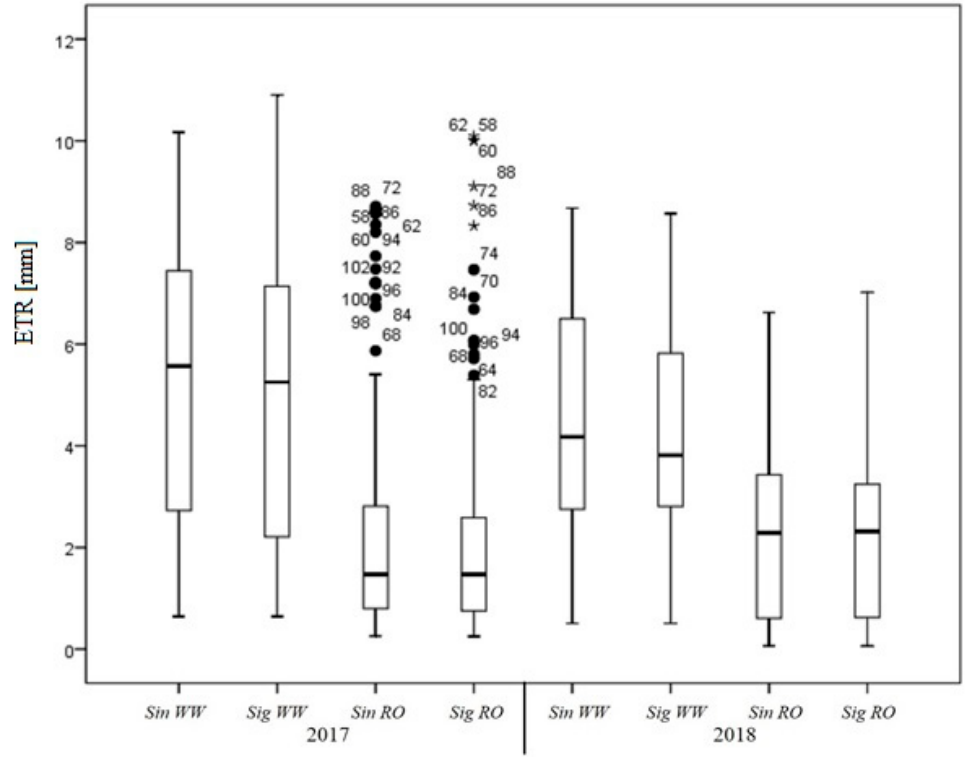
Figure 7. Daily mean evapotranspiration rates ( ETR ) of treated soybean varieties ( Sinara : Sin ; Sigalia : Sig ) under unlimited ( WW ) and limited ( RO ) watering levels through two consecutive growing seasons (2017 and 2018) at Keszthely.